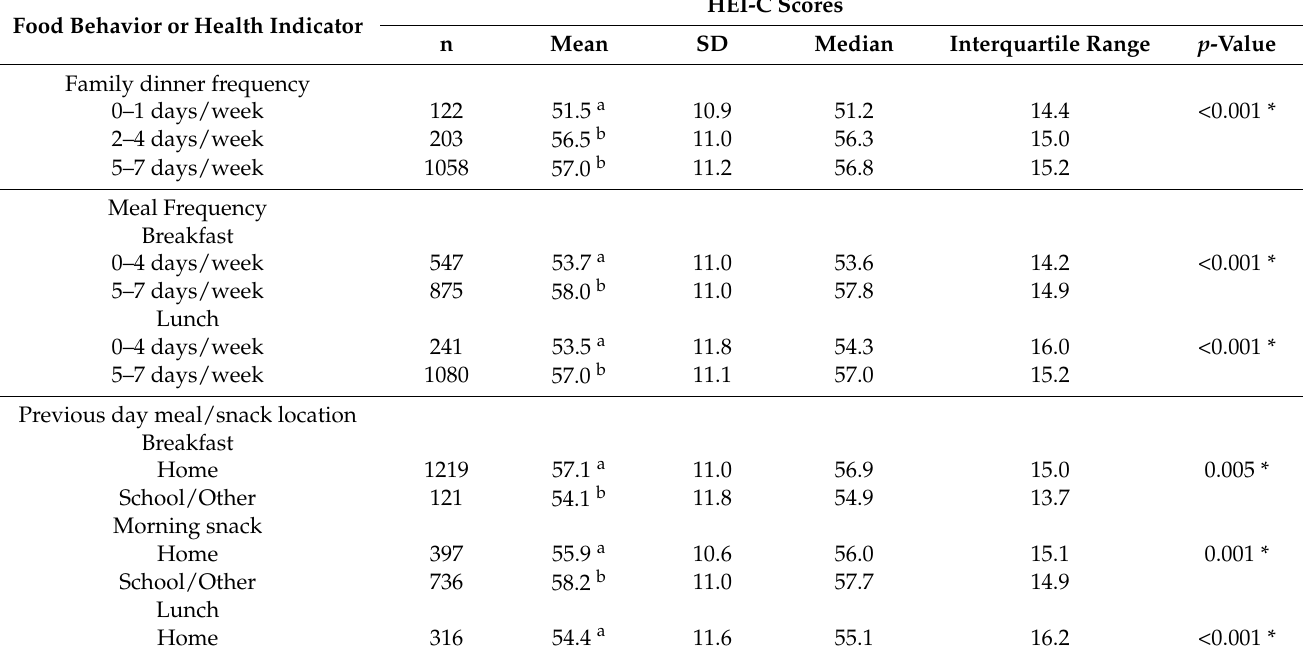
Table 2. Comparisons of HEI-C scores by food behaviours and health